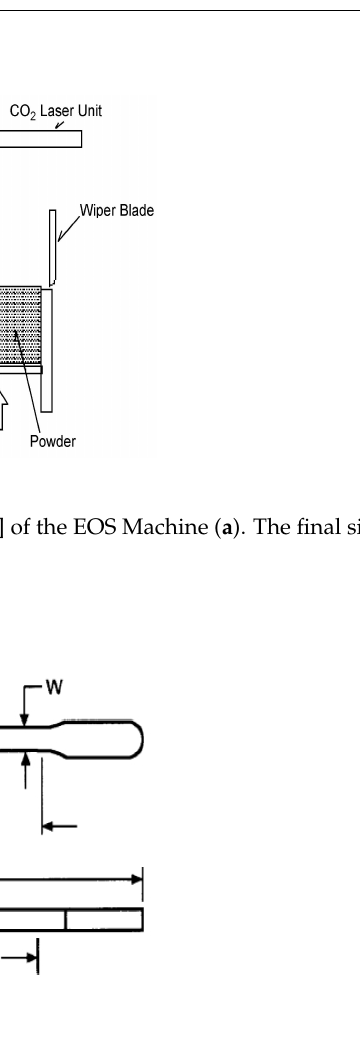
Figure 2. Flat unmachined tension test specimen [11] ( a ) and real view of samples ( b ) after sintering process. Table 4. Dimension of tension test specimen by ASTM [10].